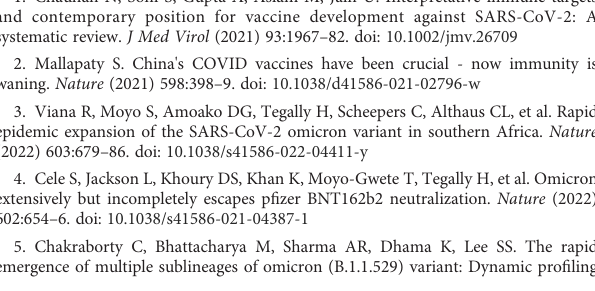
SUPPLEMENTARY FIGURE 2 Gating strategy for determining AIM + CD4 + (CD137 + OX40 + ) and AIM + CD8 + (CD137 + CD69 + ) memory T cells as well as their